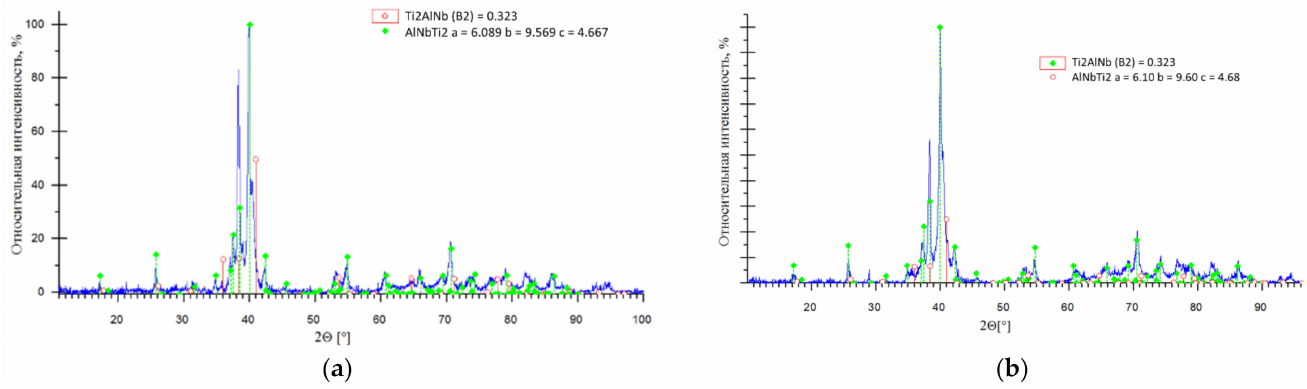
Figure 8. X-ray results of annealed samples: ( a ) MA-180; ( b )